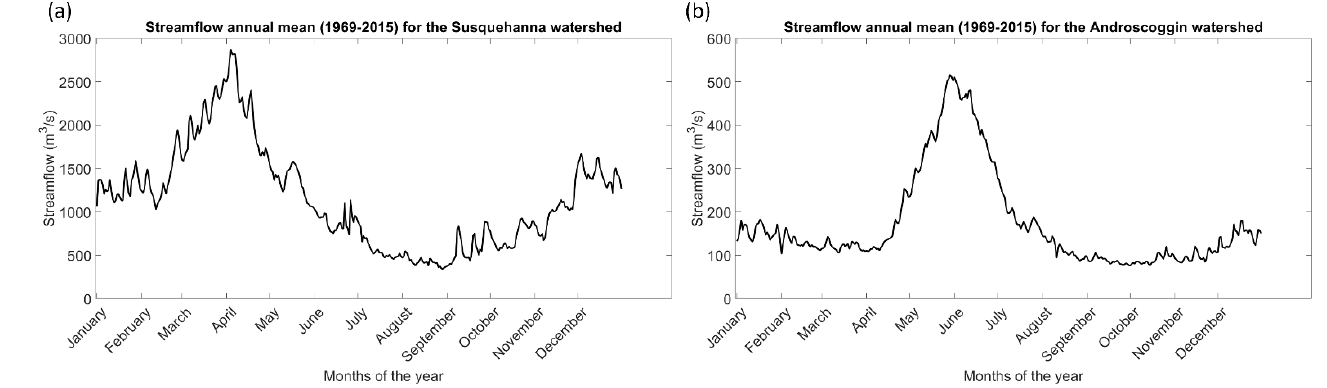
Figure 2. Mean annual streamflow for ( a ) Susquehanna and ( b ) Androscoggin watersheds, generated with datasets covering 47 years (1969–2015). Table 1. Return streamflow for four specific return periods: 2, 10, 25, and 100 years for the two watersheds, generated with datasets covering 47 years (1969–2015).